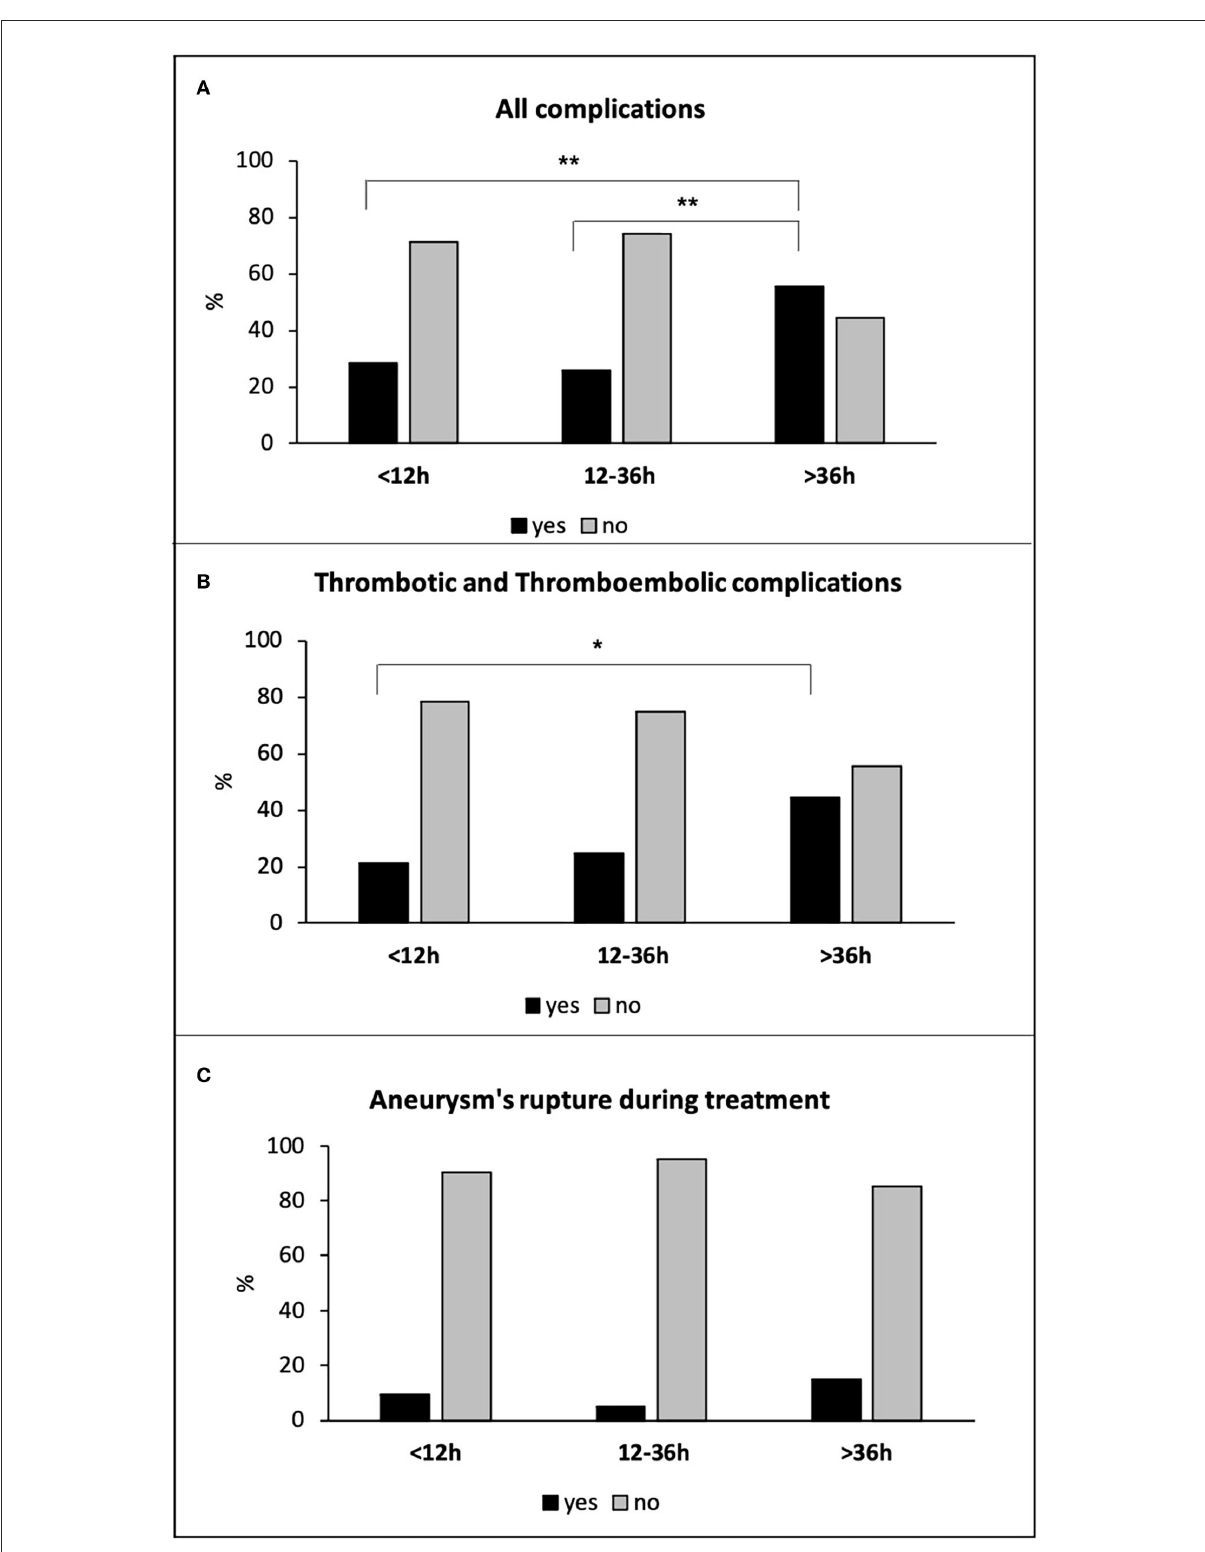
FIGURE2 All complications (A) , thrombotic and thromboembolic complications (B) , and aneurysm’s rupture during treatment (C) in all hyper-early, early, and delayed treated patients. * p < 0.05; ** p ≤